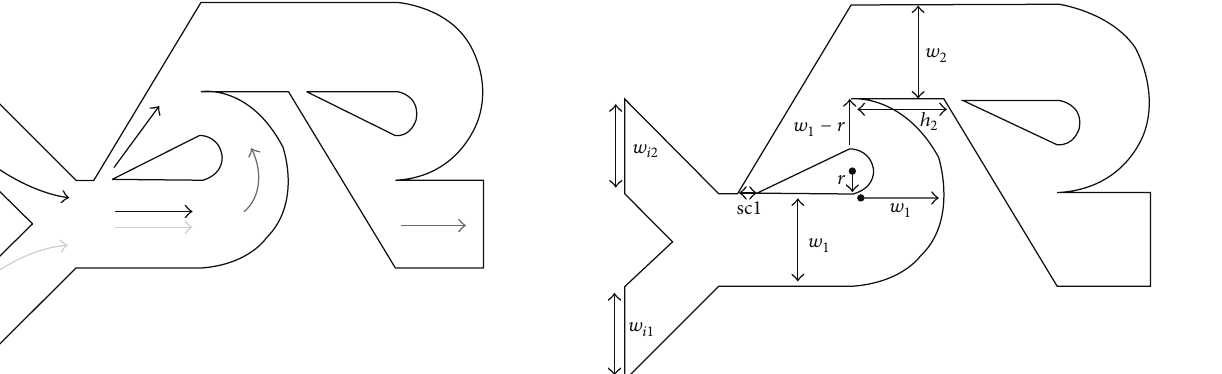
Figure 1: Layout of a passive micromixer with tesla elements.